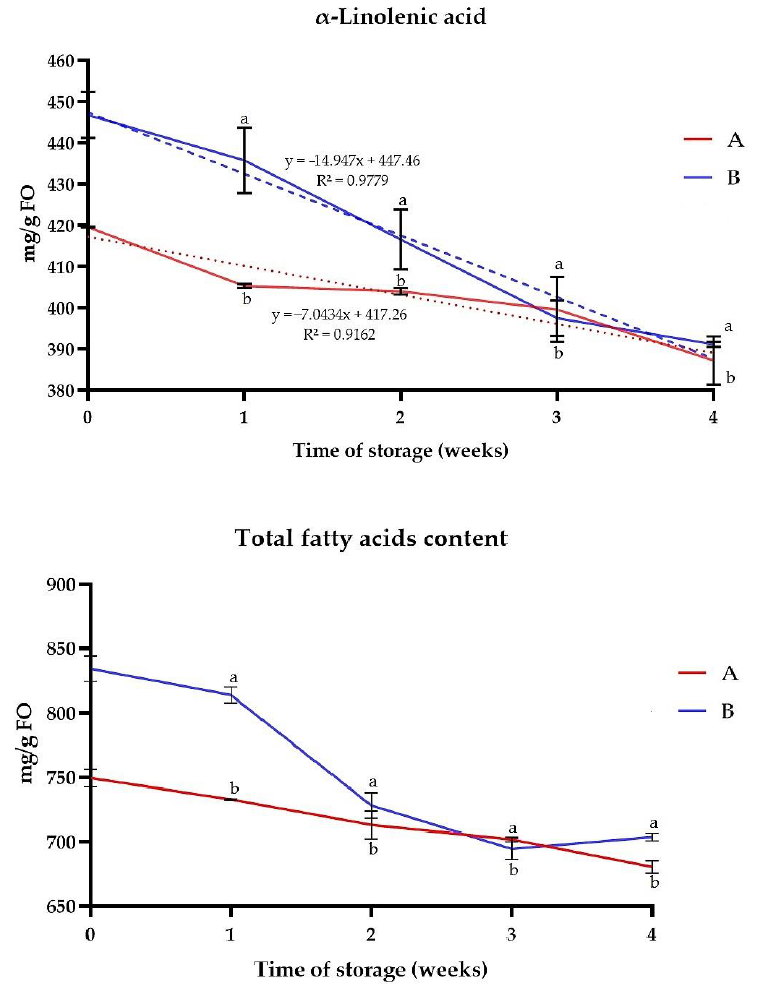
Figure 4. Changes of ALA and fatty acids content in powders containing 10% ( A ) and 20% ( B ) of FO. Means with different lowercase letters are significantly different at p < 0.05. Means with different lowercase letters are significantly different at p <